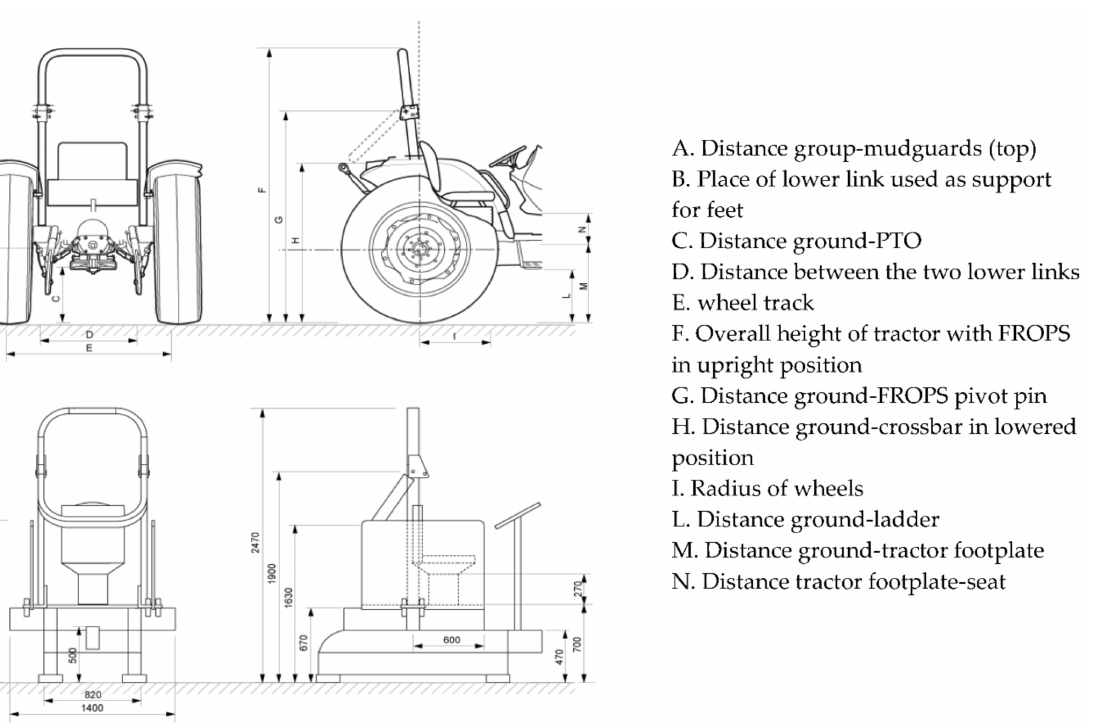
Figure 2. ( a ) Definitions of the dimensions observed on real tractors and ( b ) the dimensions (mm) of the mock-up tractors resulted and built for the